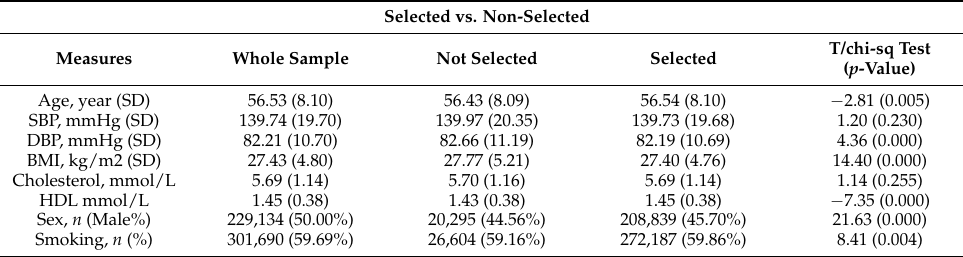
Table A1. Demographic and health characteristics of included and excluded